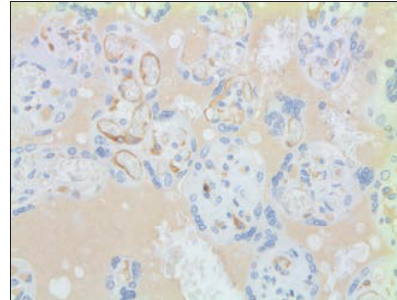
Fig. 1. A. DC-SIGN expression in Hofbauer cells in